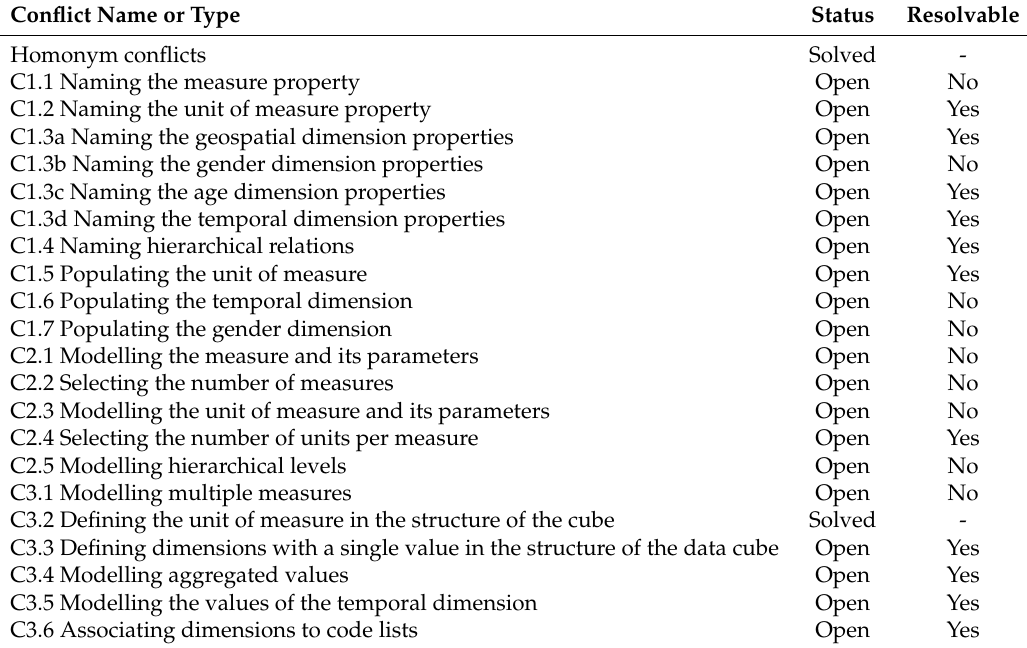
Table 39. Conflicts and their current